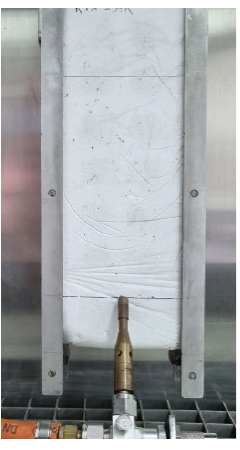
Figure 14. 90 × 250 × 20 mm 3 Fire samples.